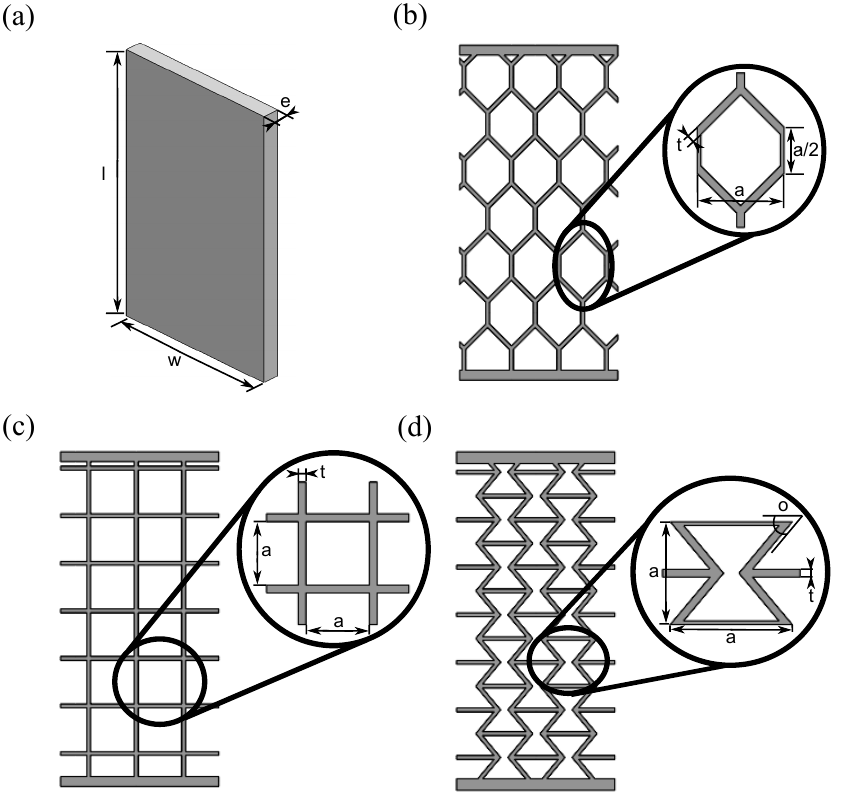
Figure 2. Schematics of the lattice-flexure hinges, showing topology designs and variables. ( a ) Constant dimensions of the flexure hinge. ( b ) Hexagonal lattice-flexure hinge with a unit cell di- mension of 3.5 mm and an orientation of 0°. ( c ) Square lattice-flexure hinge with a unit cell dimension of 3.5 mm and an orientation of 0°. ( d ) Re-entrant lattice-flexure hinge with a unit cell dimension of 5.5 mm and an orientation of 0°.